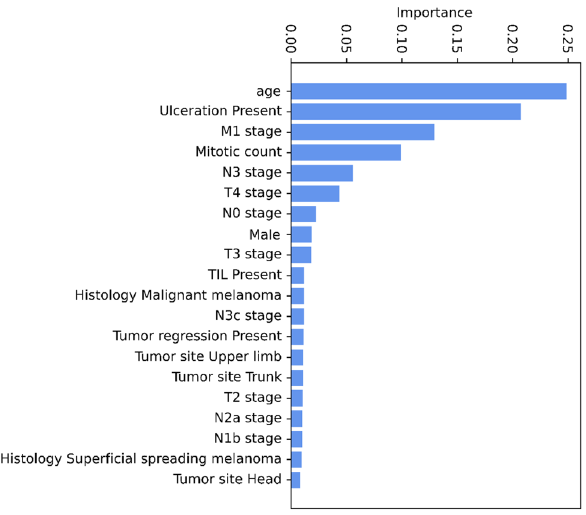
Fig. 5 RF model most impor- tant features in predicting CMM risk according to the Gini impurity